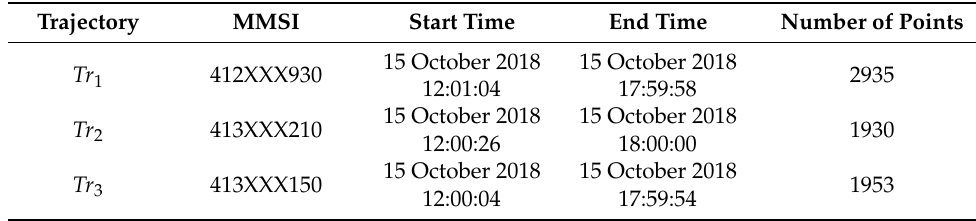
Figure 7. Trajectories 1 Table 3. Trajectories in case study.